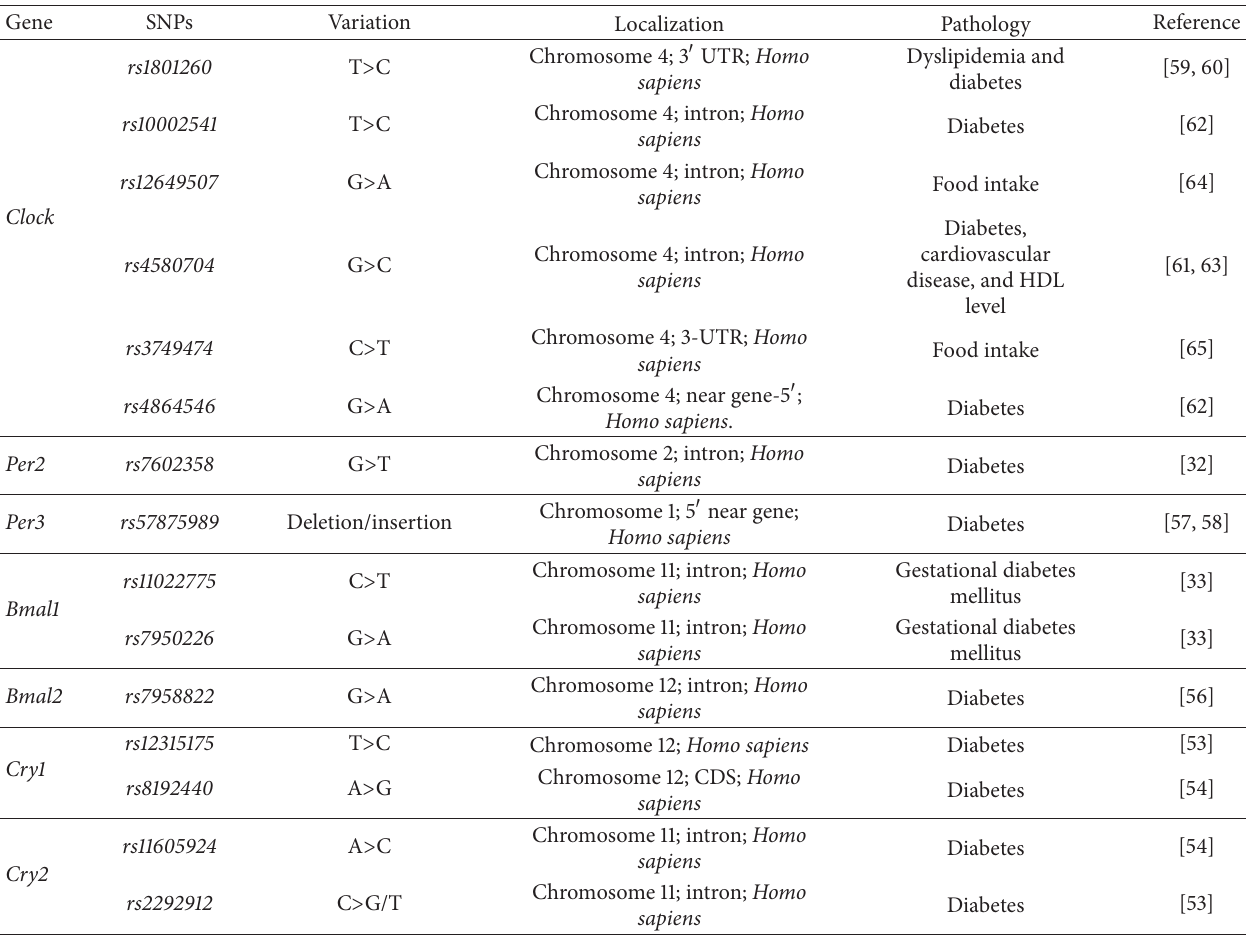
Table 1: Polymorphisms of clock genes associated with metabolic